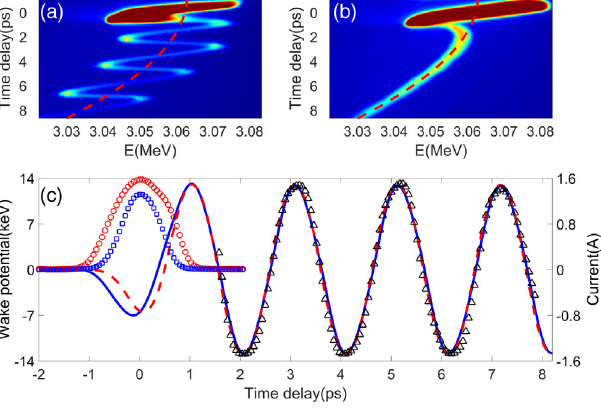
FIG. 2. Electron beam time-energy map with (a) and without (b) the dielectric tube. The red dashed line shows the curvature of the rf field and the saturated region represents the drive beam with high intensity. (c) Measured longitudinal wake potential (black triangles) and the calculation (red dashed line) using the measured beam distribution at the deflector (red circles). For comparison, the retrieved leading beam distribution at the dielectric tube (blue squares) and its corresponding wake poten- tial (blue solid line) are also shown.